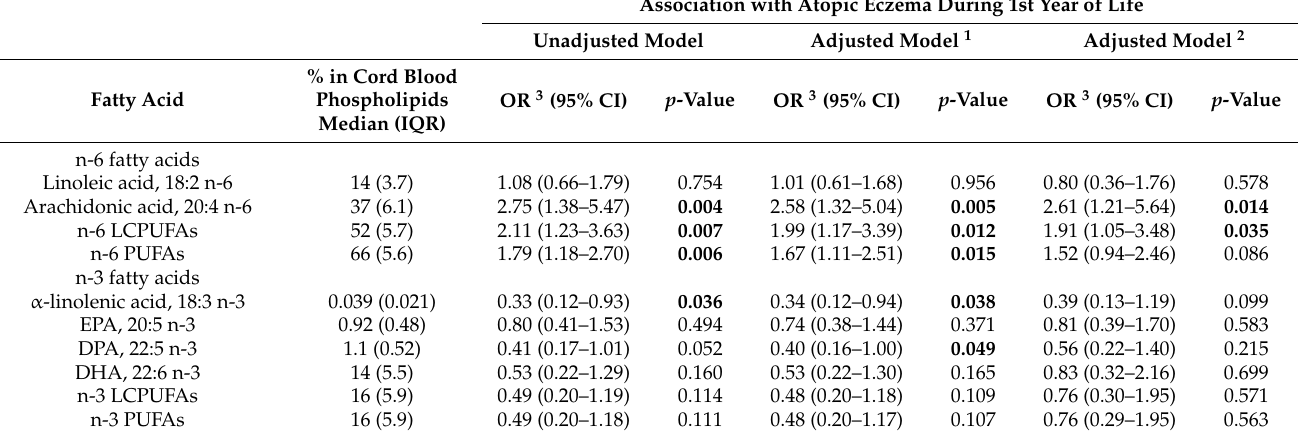
Table 2. Associations between one unit increase in IQR for the proportions of different polyunsaturated fatty acids (PUFAs) in cord serum phospholipids and atopic eczema during the first year of